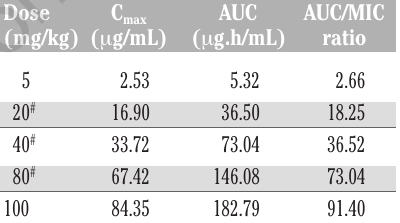
Table 2. Selected pharmacokinetics param- eter of linezolid estimated in Swiss albino mice.